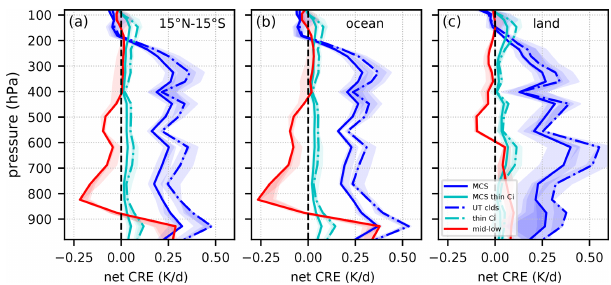
Figure 5. Tropical mean net radiative heating effect within the tro- posphere of low- and mid-level clouds (red) and UT clouds (broken blue line), for the latter the effect of MCSs (blue), thin cirrus sur- rounding MCSs (cyan, full line) and all thin cirrus (broken cyan line) is shown separately. (a) All, (b) ocean and (c) land. Cloud observations averaged over 01:30 and 13:30LT, with SW radiation normalized to 24h, similar to Li et al. (2013). Statistics of 15 years (2004–2018), averaged over 15 ◦ N to 15 ◦ S. The sum of UT cloud and mid- and low-level cloud contributions corresponds to the to- tal cloud heating effect, defined as the difference between total and clear-sky